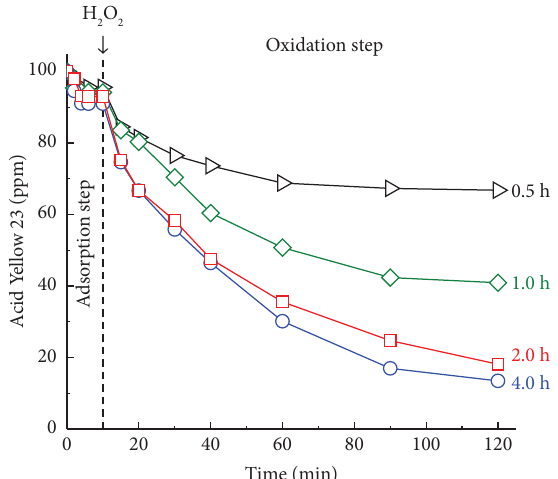
Figure 10: Efect of washing MPC catalyst on AY23 decolorization (0.80 g/L MPC-R0.2–2.0h, initial pH 6.0, 200ppm H 2 O 2 ).